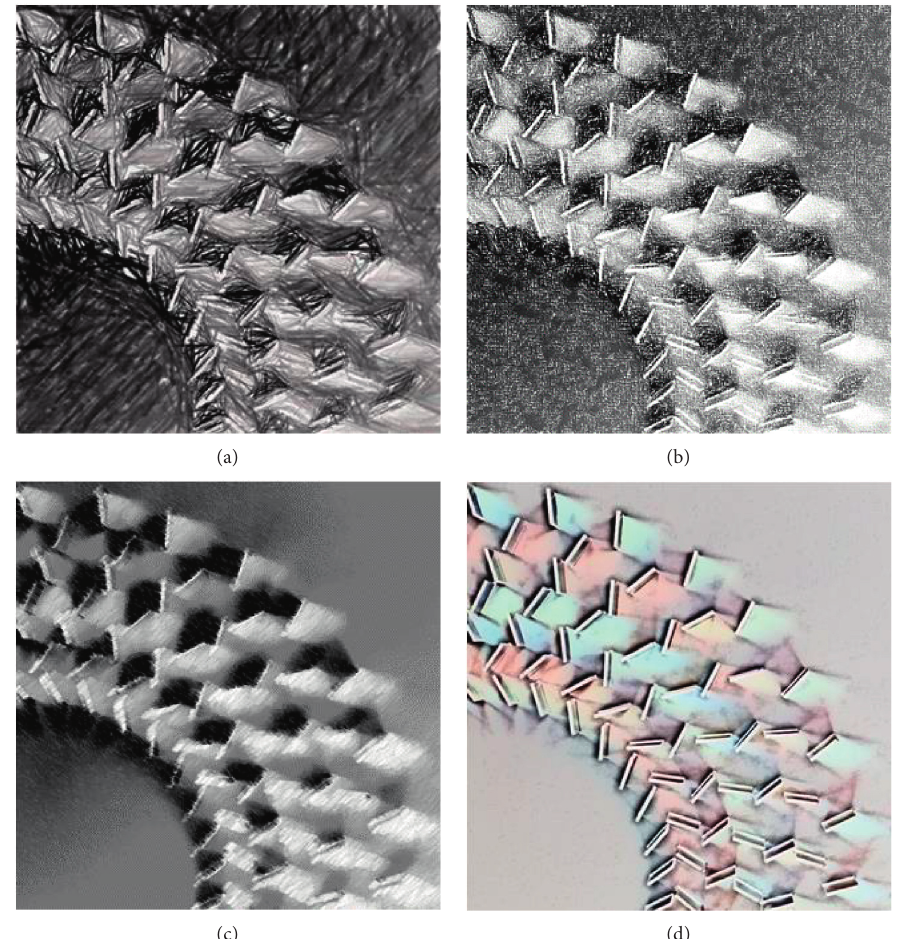
Figure 6: Processing of reflective images by different operators. (a) Prewitt operator. (b) Sobel operator. (c) Laplacian operator. (d) 0.3-order fractional